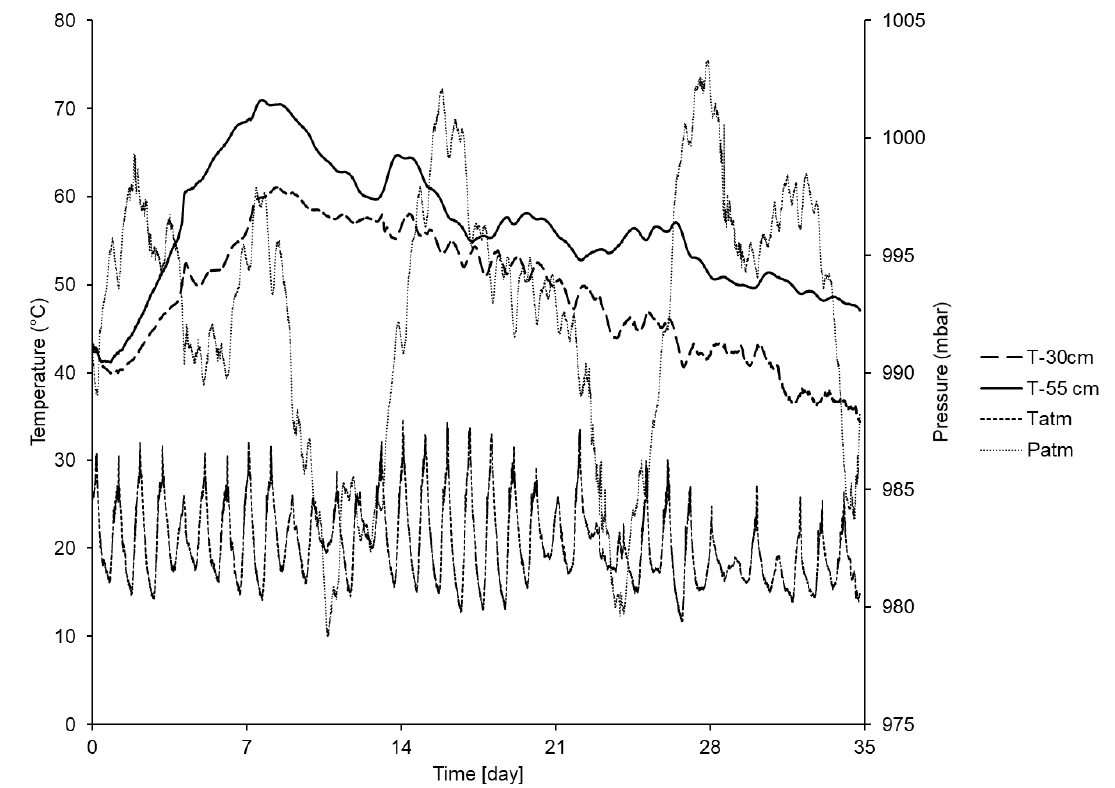
Figure 4. The temperature and environmental conditions evolution in Test 2.